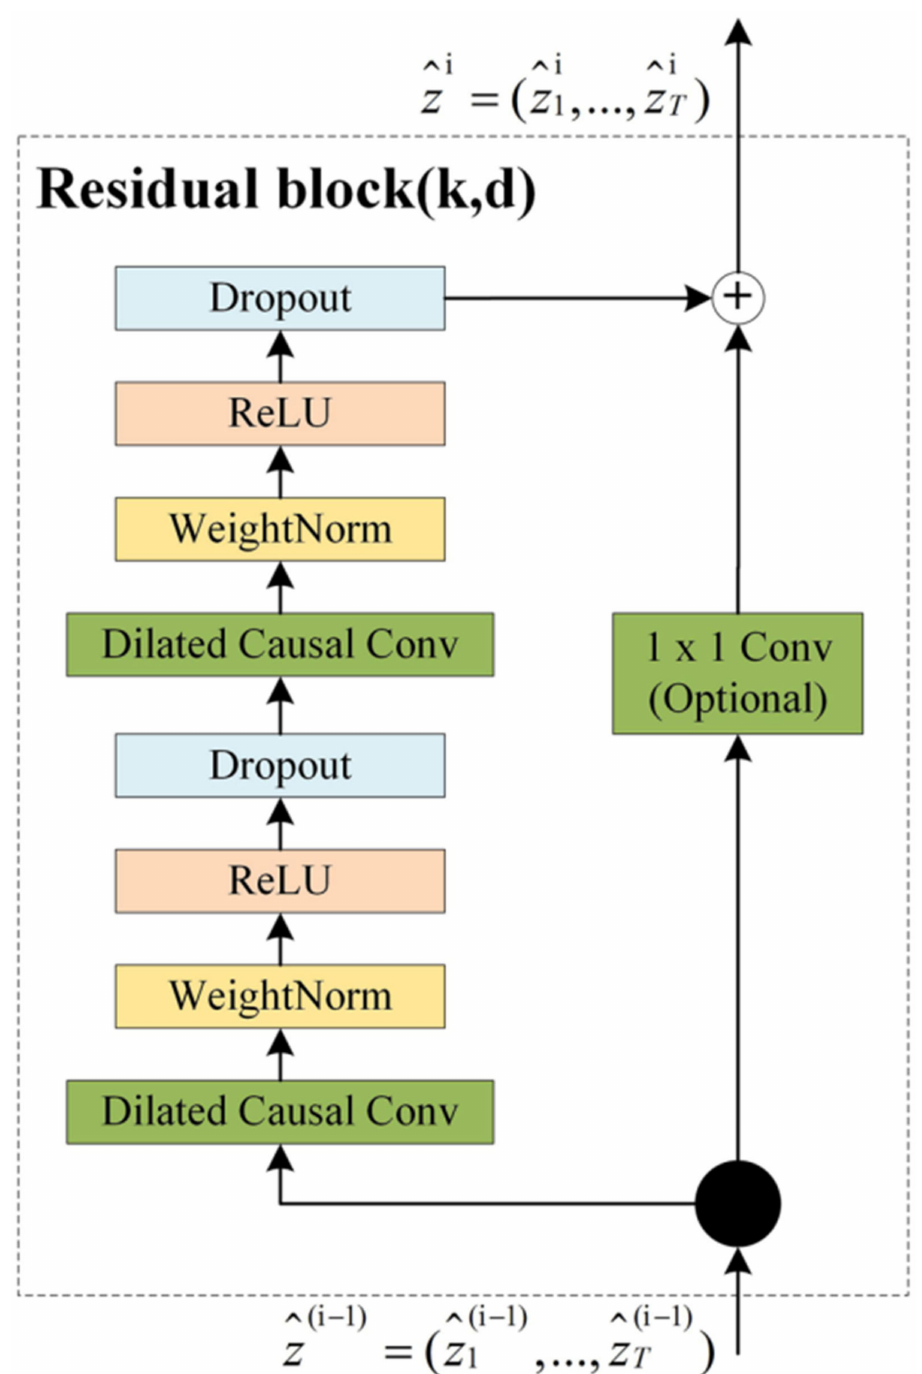
Figure 4. The TCN residual module